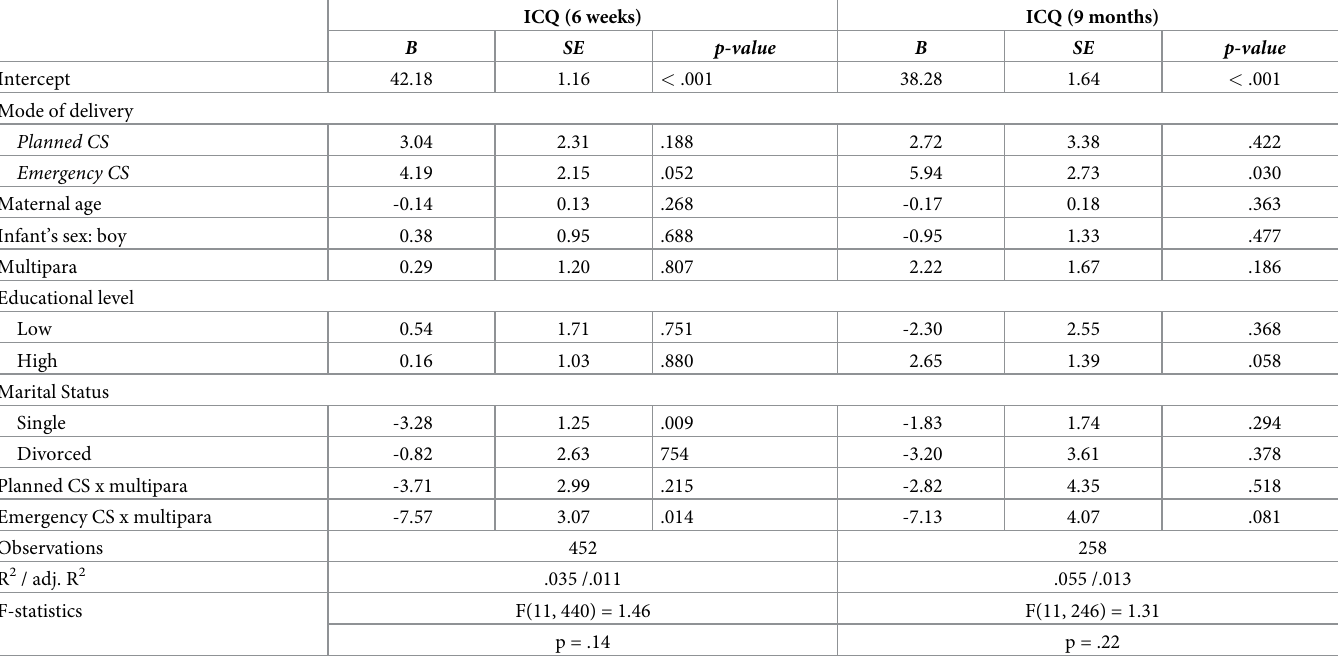
Table 3. Association between the mode of delivery and infant temperament—Interaction with parity.